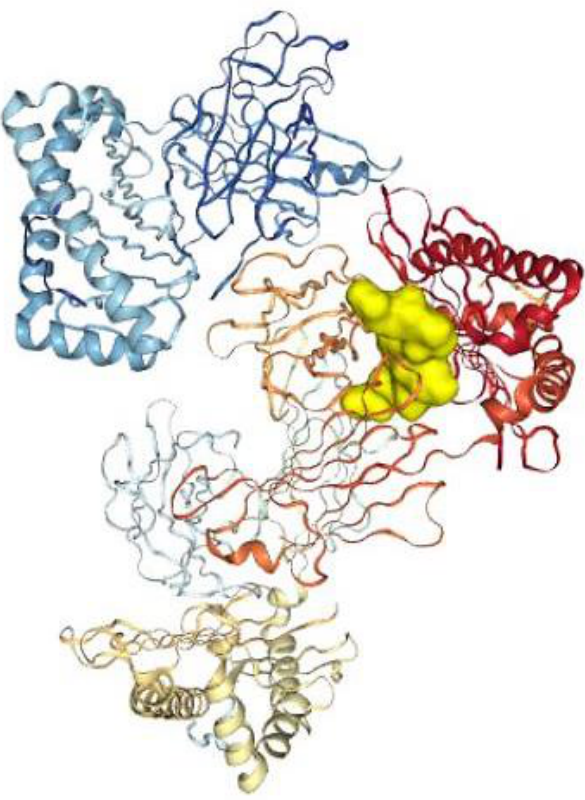
Figure 4. The peptide LSLPVLQVR is shown in the surface (yellow) format which has been docked against the HLA-A*11- 01, displayed in the ribbon format. The format of the allele and the peptide are differed on purpose to show distinction.